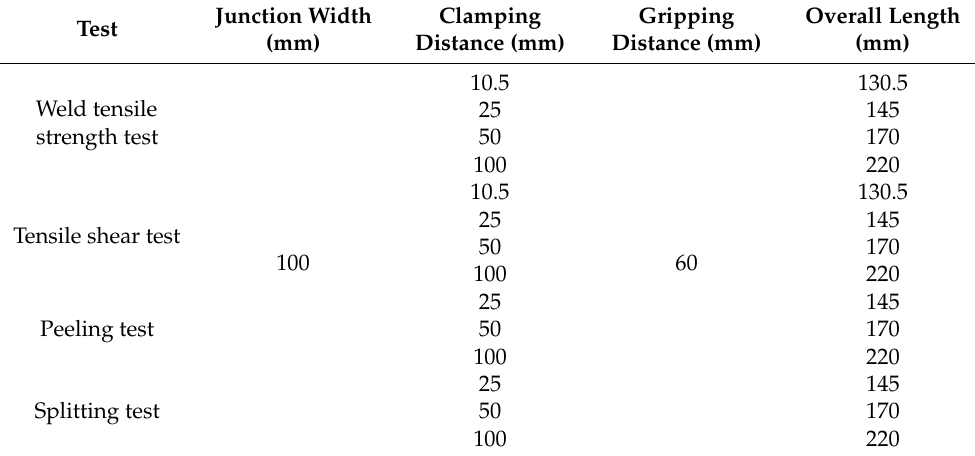
Table 2. Specimen